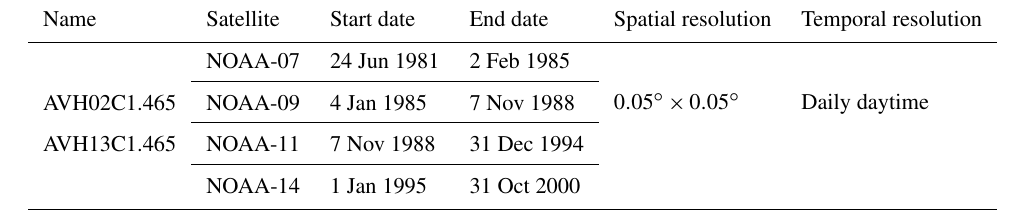
Table 1. Details of the selected AVHRR datasets.